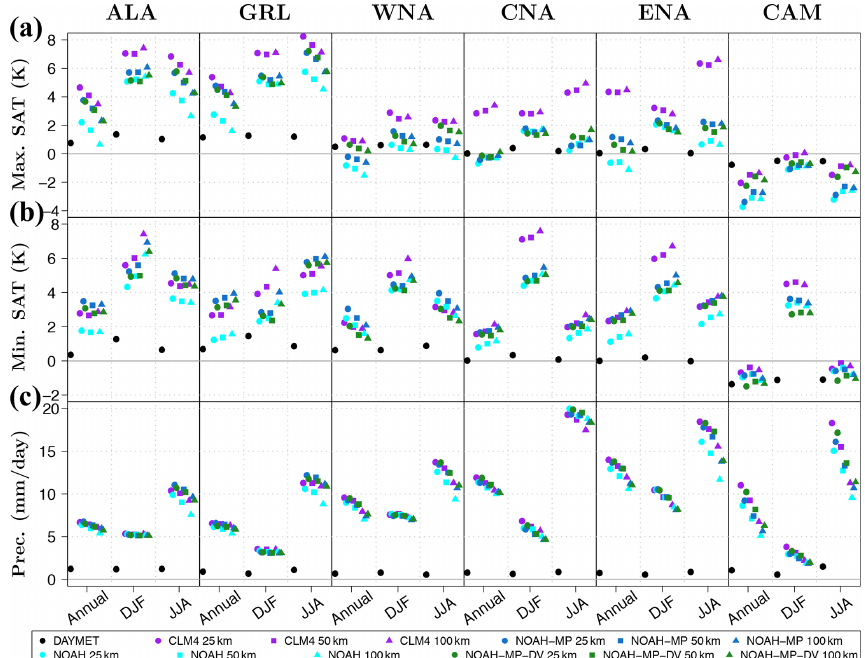
Figure 10. Regional mean annual and seasonal biases in extreme maximum and minimum temperatures ( ◦ C) and in extreme precipitation (mmd − 1 ) for all experiments and the DAYMET data product relative to the CRU database from 1980 to 2013. Extremes are calculated as the 95th percentile of the annual and seasonal temporal series at each grid cell. Biases are estimated averaging over six subregions (Fig. 1) adapted from Giorgi and Francisco (2000): Central America, CAM; western North America, WNA; central North America, CNA; eastern North America, ENA; Alaska, ALA; and Greenland,